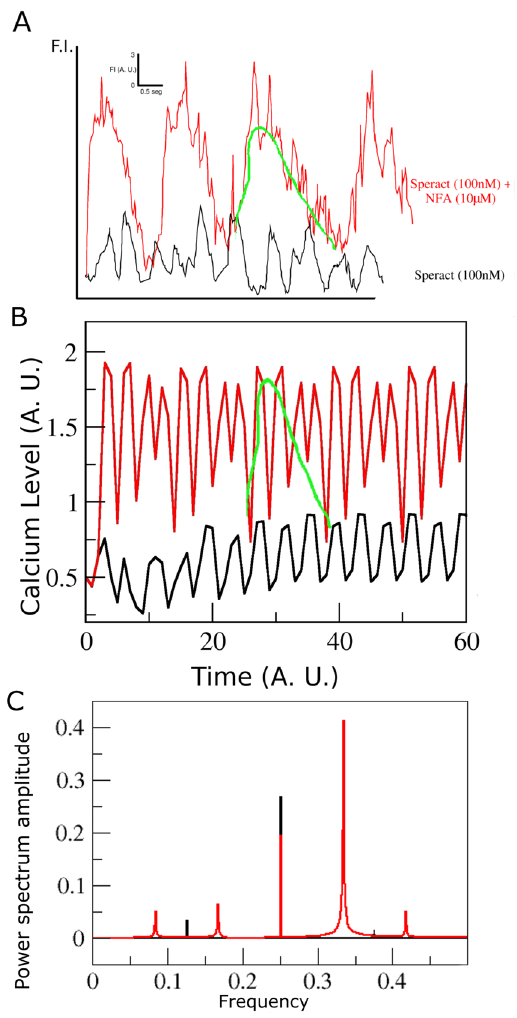
Figure 7. Comparison between experiments on the effect of niflumic acid (NFA) and the network dynamics of Model-III. ( A ) Experimental [ Ca 2 + ] i curves using 100 nM of speract (black) and 100 nM of speract + 10 μ M of NFA (red). Notice that the average [ Ca 2 + ] i mean, amplitude, maximum peak and interval between peaks is higher in the red curve (with NFA) than in the WT curve. ( B ) Ca 2 + time series generated from Model-III with all nodes present in black, and in red the “NFA case”, with HCN, CaCC channels blocked and CaKC, CatSper channels over activated. The green curve is placed as a guide to the eye for an envelope of both experiment and model series. ( C ) Fourier spectra of the above time series, with same colour code. Notice the more elaborate temporal behaviour and higher period component in the red